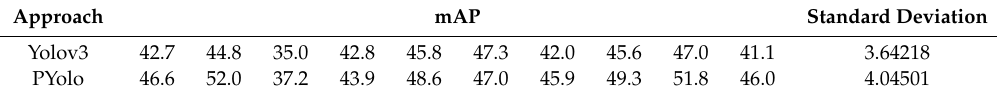
Table 9. Statistical significance (%).